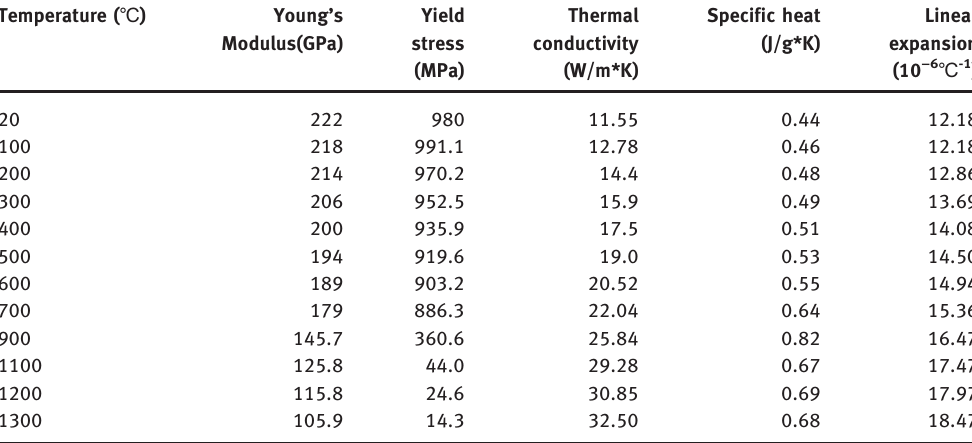
Table 2: Material properties of GH80A.